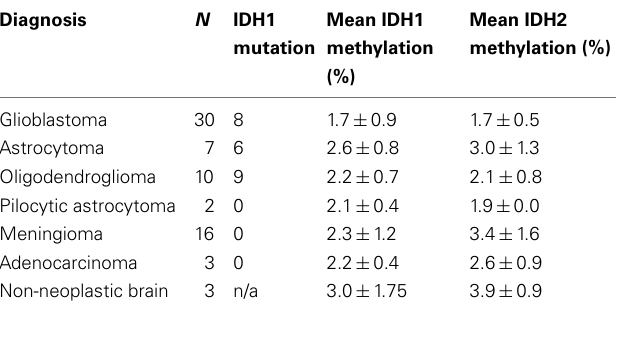
Table 1 |Tumors tested, IDH1 mutation status, and mean methylation